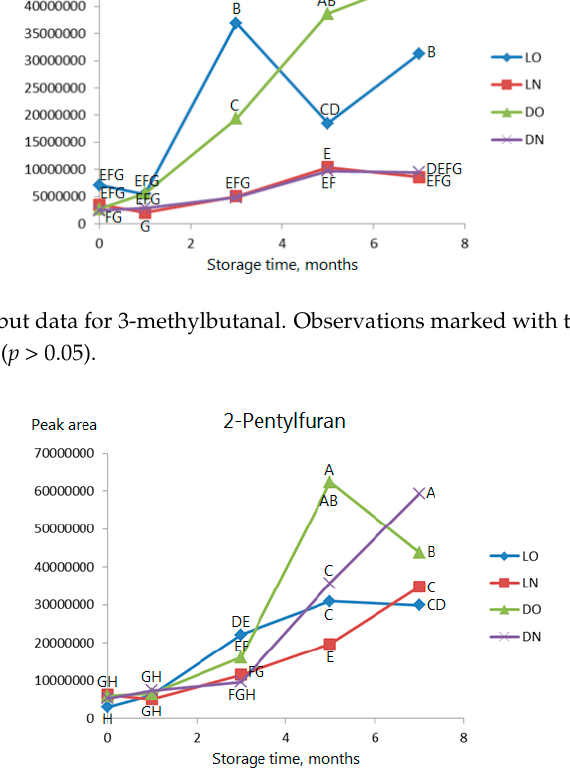
Figure 5. As Figure 3 but data for 2-pentylfuran. Observations marked with the same letter are not significantly different ( p > 0.05).